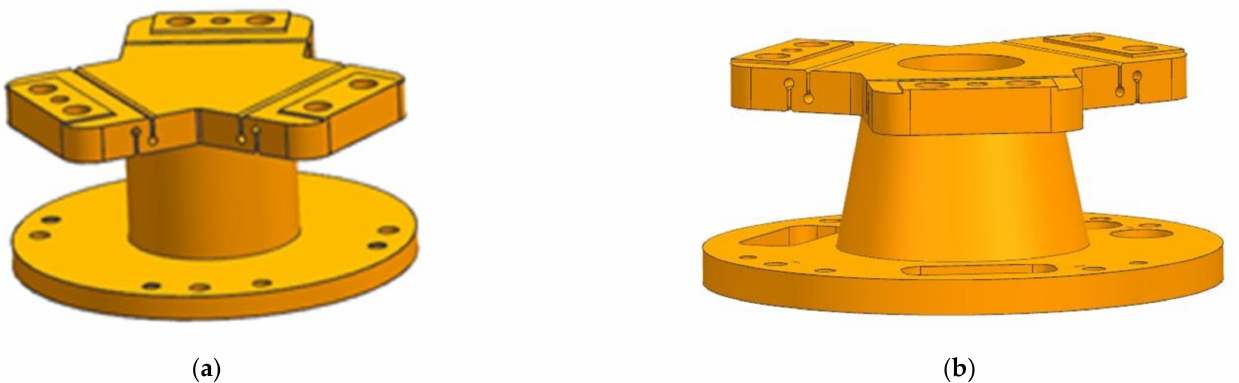
Figure 5. The flexure of the space mirror assembly ( a ) the initial structure of flexure; ( b ) the improved